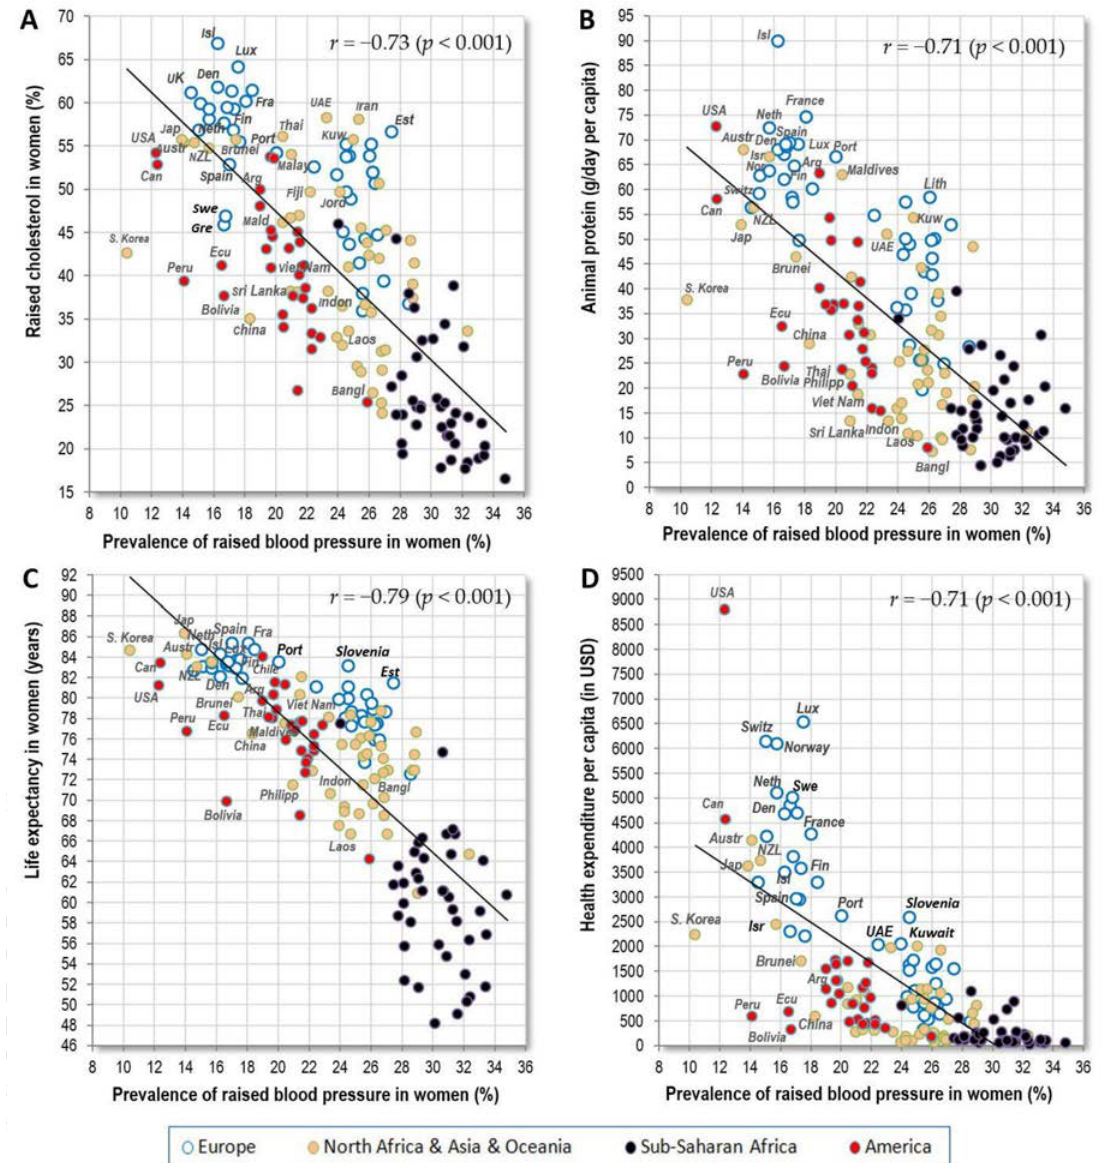
Figure 4. ( A ) Relationship between the prevalence of women’s raised blood pressure (%; WHO, 2010) and the prevalence of women’s raised cholesterol (%) (WHO, 2008); ( B ) Relationship between the prevalence of women’s raised blood pressure (%; WHO, 2010) and the mean consumption of animal protein (g/day per capita; FAOSTAT, 1993–2011); ( C ) Relationship between the prevalence of women’s raised blood pressure (%; WHO, 2010) and women‘s life expectancy (World Bank, 2012). ( D ) Relationship between the prevalence of women’s raised blood pressure (%; WHO, 2010) and health expenditure per capita for 2012 (in